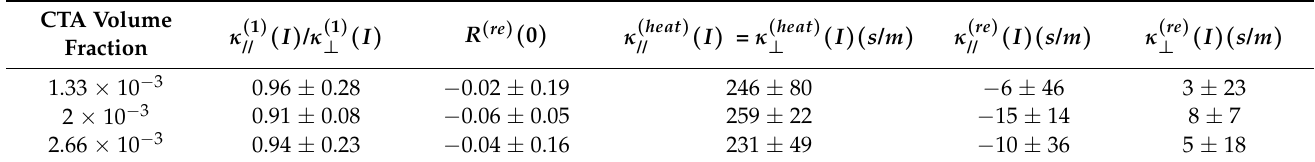
Table 6. Contribution of photothermal heating and angular hole burning to the photomechanical